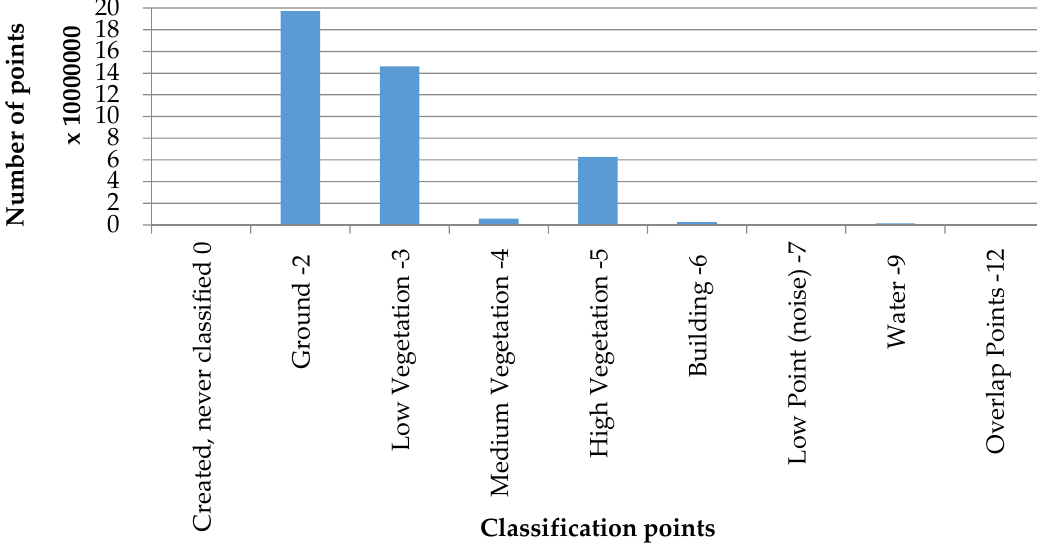
Figure 3. Point classification histogram.